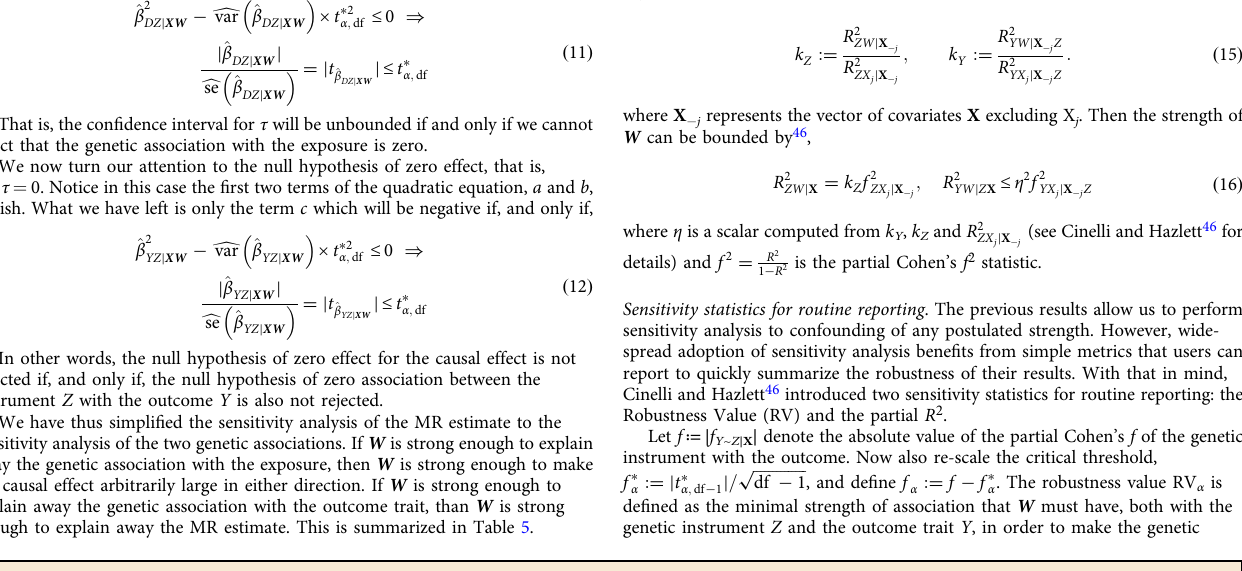
Table 5 The sensitivity of the Mendelian Randomization (MR) causal effect estimate can be decomposed into the sensitivity of its two components: the sensitivity of the genetic association with the exposure and the sensitivity of the genetic association with the